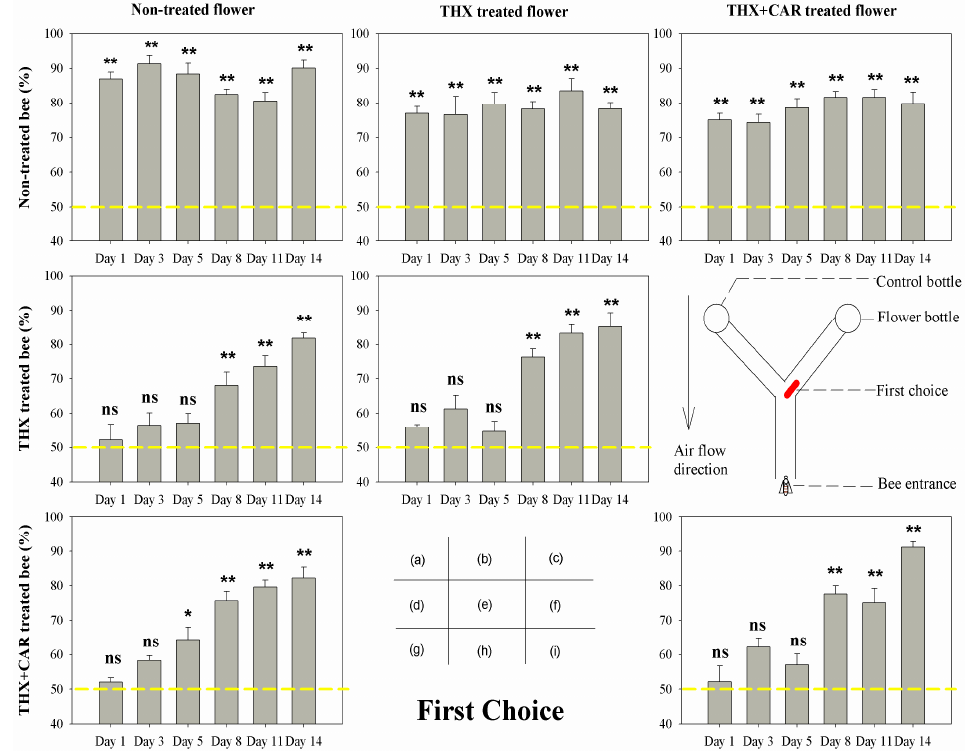
Figure 1. The first choice of bee orientation behavior in Y maze treated with thiamethoxam (THX) and thiamethoxam + carbendazol mixture (THX + CAR). The X-axis presented the time post-treatment (Day). The red bold line in diagram (f) showed the first choice of a bee enter to flower arm. The yellow dash line showed the reference line of 50%, * presents significant difference ( p < 0.05), ** presents great significant difference ( p < 0.01), ns means no significant difference ( p > 0.05).